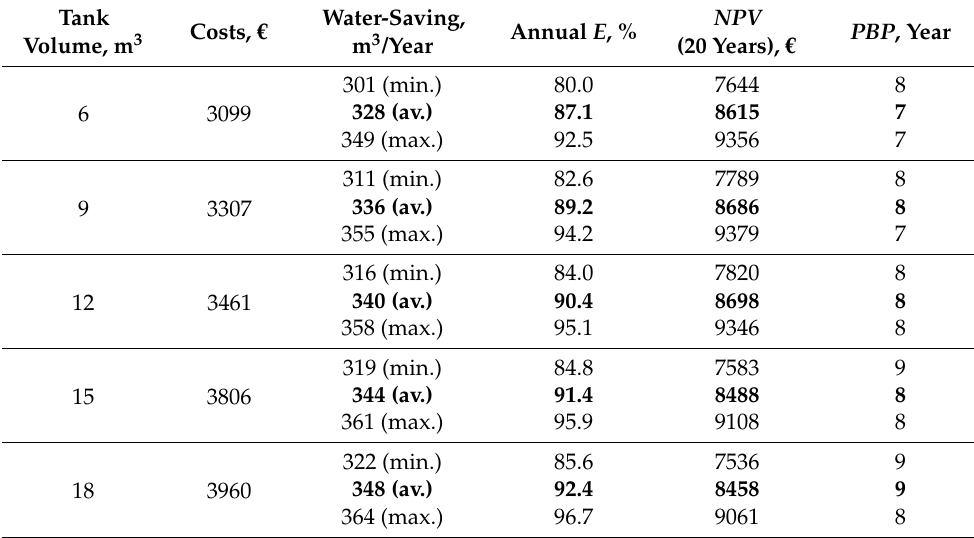
Table 2. NPV and PBP values related to each tank size for the combined